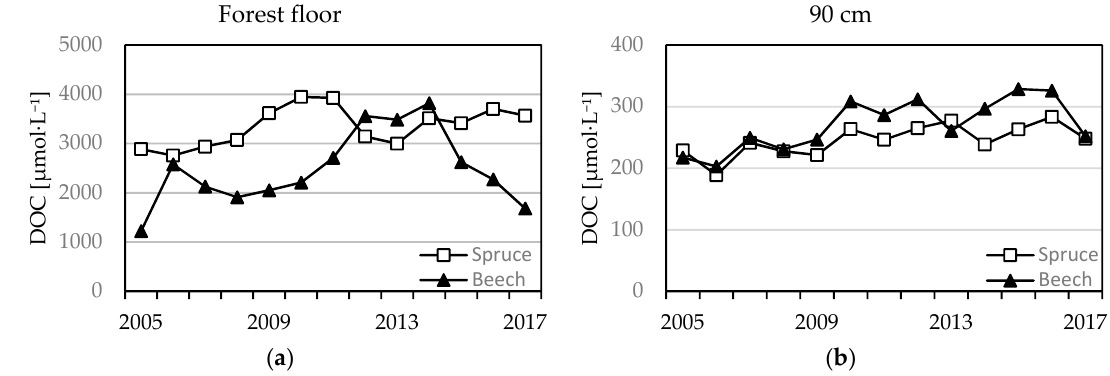
Figure 8. Mean annual molar DOC concentrations from forest floor ( a ) and the 90 cm ( b ) horizons of beech and spruce soil solutions.